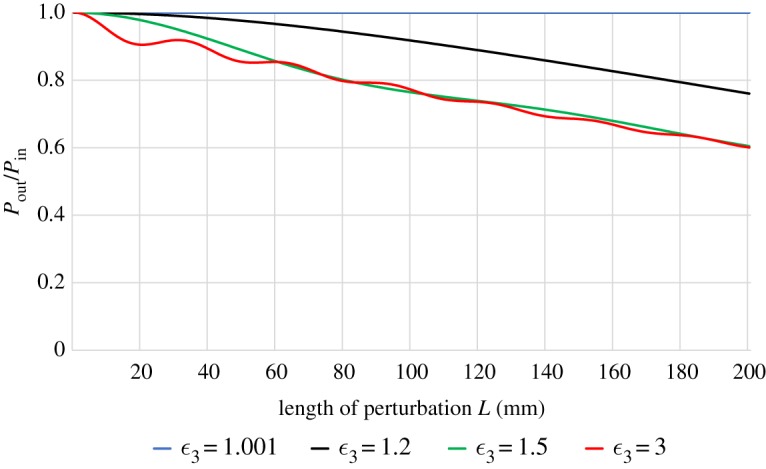
Normalized transmitted power as a function of the length of the perturbing dielectric L, which is a distance y2 = 2 cm away from the conductor at 15 GHz. The dielectric constant of the perturbation is varied and given in the legend as relative permittivities. When ϵ3/ϵ2 is approximately 1, no loss is seen. As it increases, the surface wave becomes more lossy until the effect saturates and the average loss becomes only weakly dependent on the permittivity except for very short perturbations. However, the interference pattern still depends on the exact dielectric constant. (Online version in colour.)